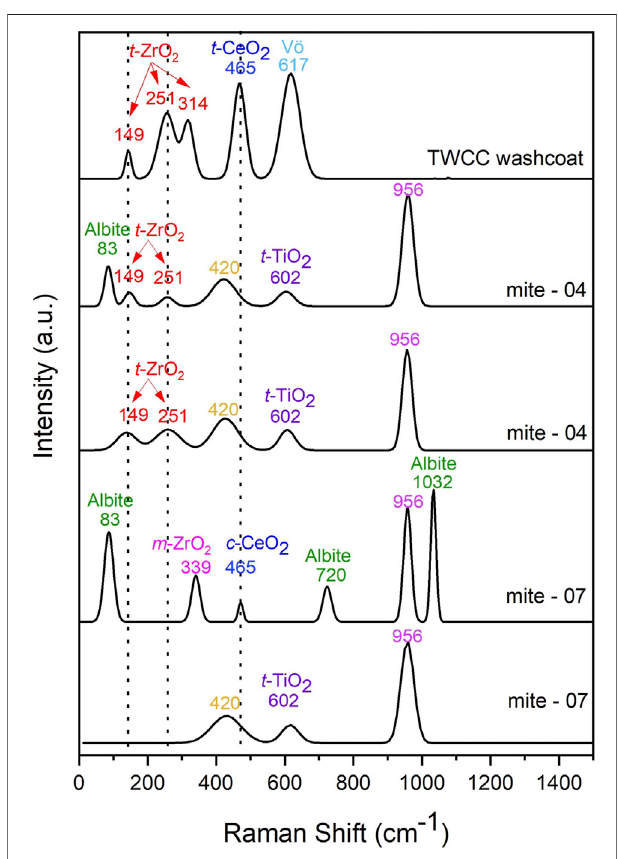
FIGURE 6 | Raman spectra for the TWCC washcoat, and particles in Hannemania mites.